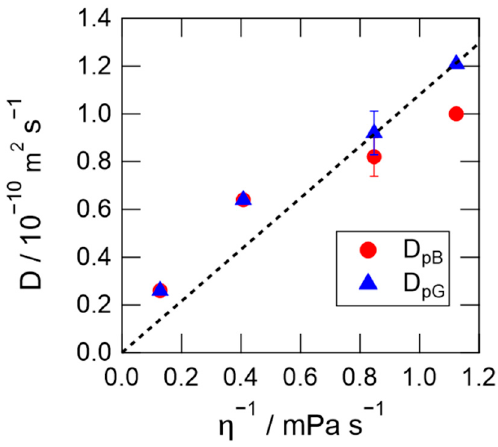
Figure 7. Dependence of diffusion coefficients on the inverse of the viscosity.